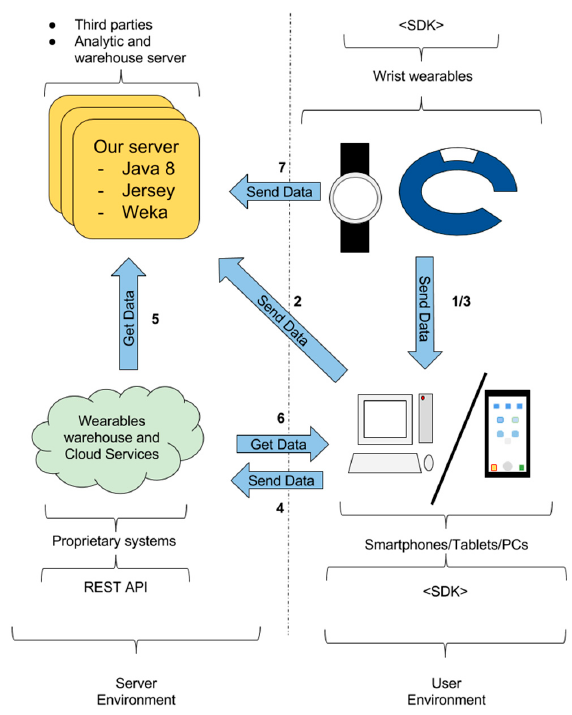
Figure 4. Systems involved in the smartwatch data collection scenario.